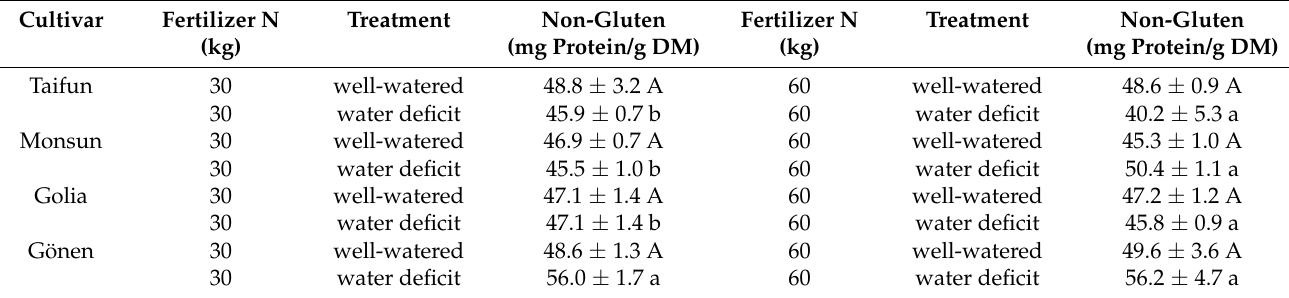
Table 2. Protein content of non-gluten (mean ± SE mg protein/g DM) at maturity of spring wheat cultivars influenced by N fertilization of 30 or 60 kg N applied at the beginning of heading (EC 51) of well-watered and water deficit plants, with the beginning at the end of heading (EC 59) for 21 days. (for each N level: well-watered plants: different capitals indicate significant differences between cultivars, Tukey HSD test, p = 0.05, n = 3; water deficit plants: different small letter indicates significant differences between cultivars, Tukey HSD test, p = 0.05, n =